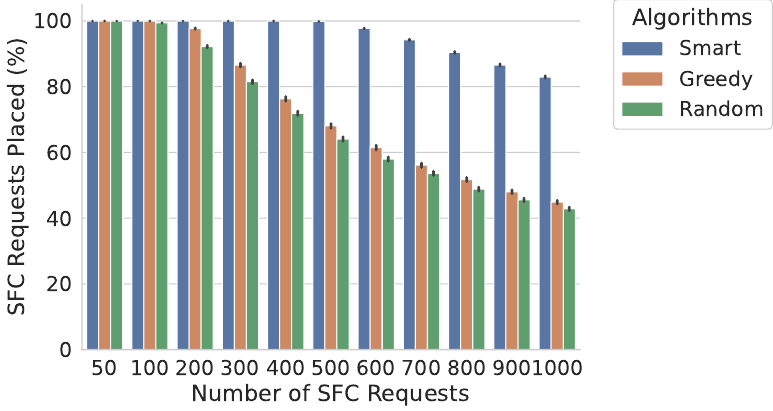
Figure 7. Percentage of placed SFC requests.